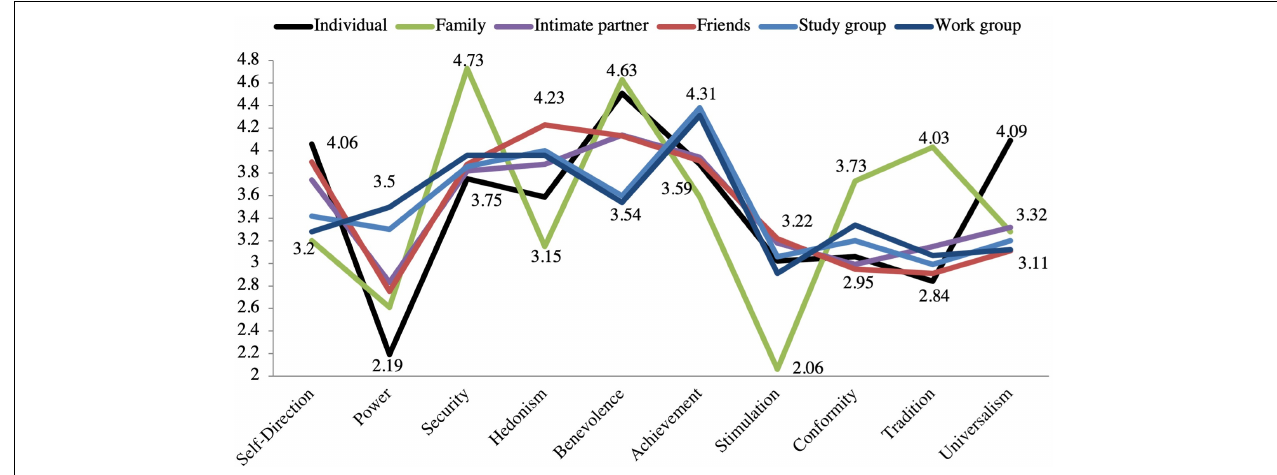
FIGURE 4 | The general importance of the social contexts